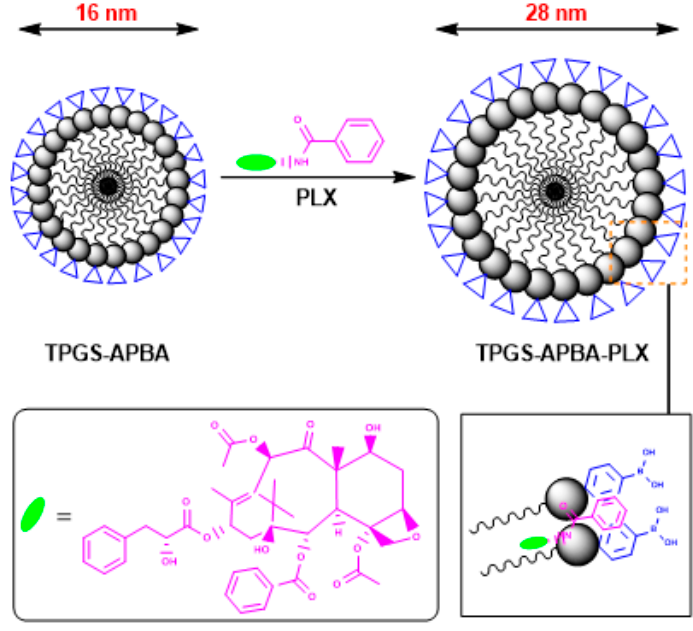
Figure 4. A proposed scheme showing intercalation of PLX molecules in the head group region to stack over APBA via π – π forces.